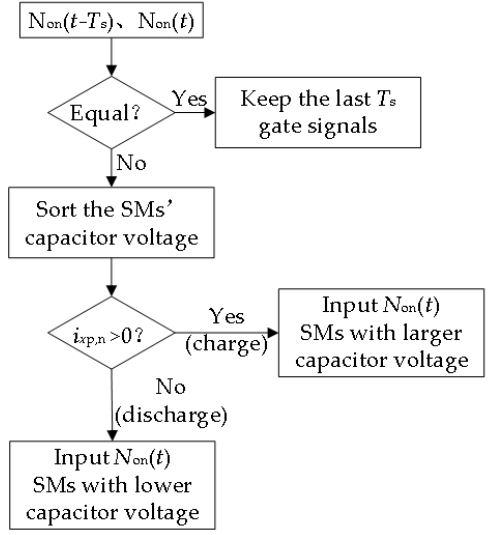
Figure 9. Capacitor voltage sorting algorithm.